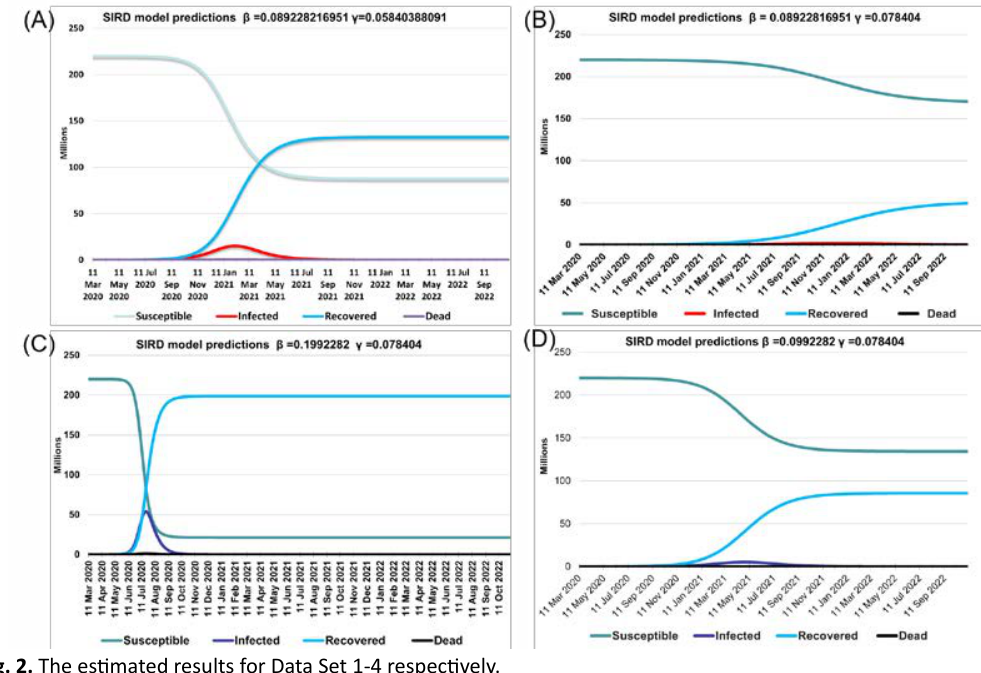
Fig. 2. The estimated results for Data Set 1-4